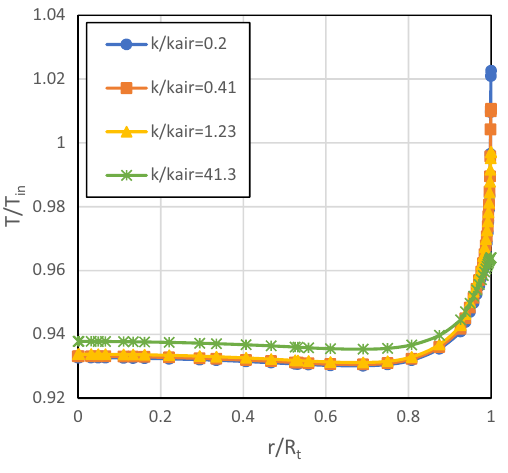
Fig. 12 Dimensionless static temperature profiles versus dimen- sionless radial direction plotted at z∕L = 0.63 for various thermal conductivity ratios with 400 kPa at the inlet, 0 kPa at the cold outlet and 30 kPa at the hot